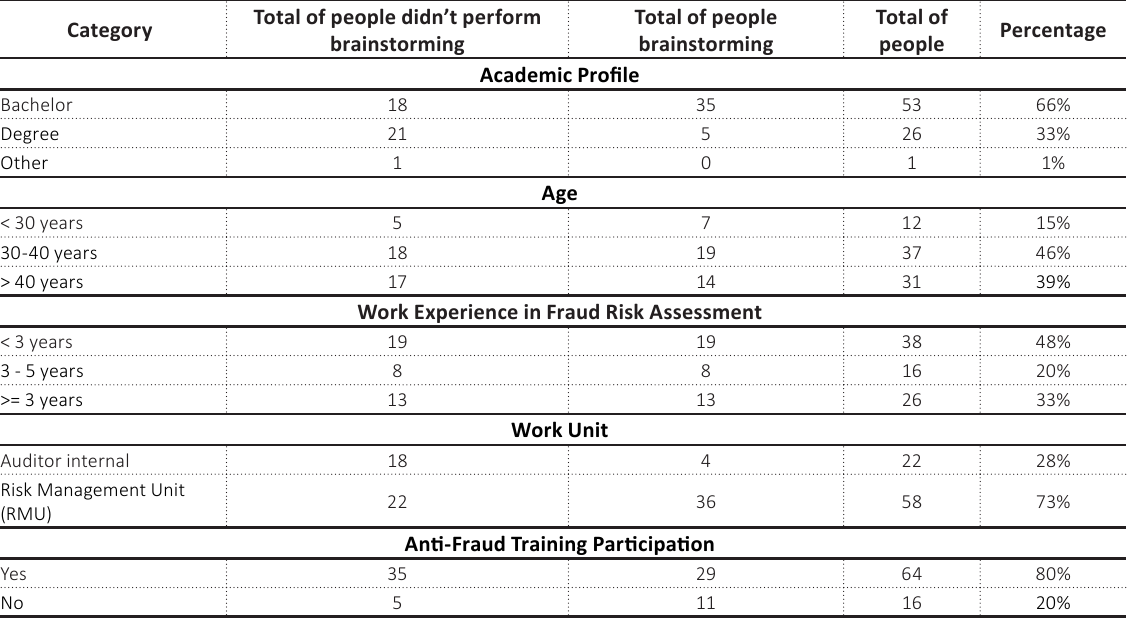
Table 2. Demographic statistics